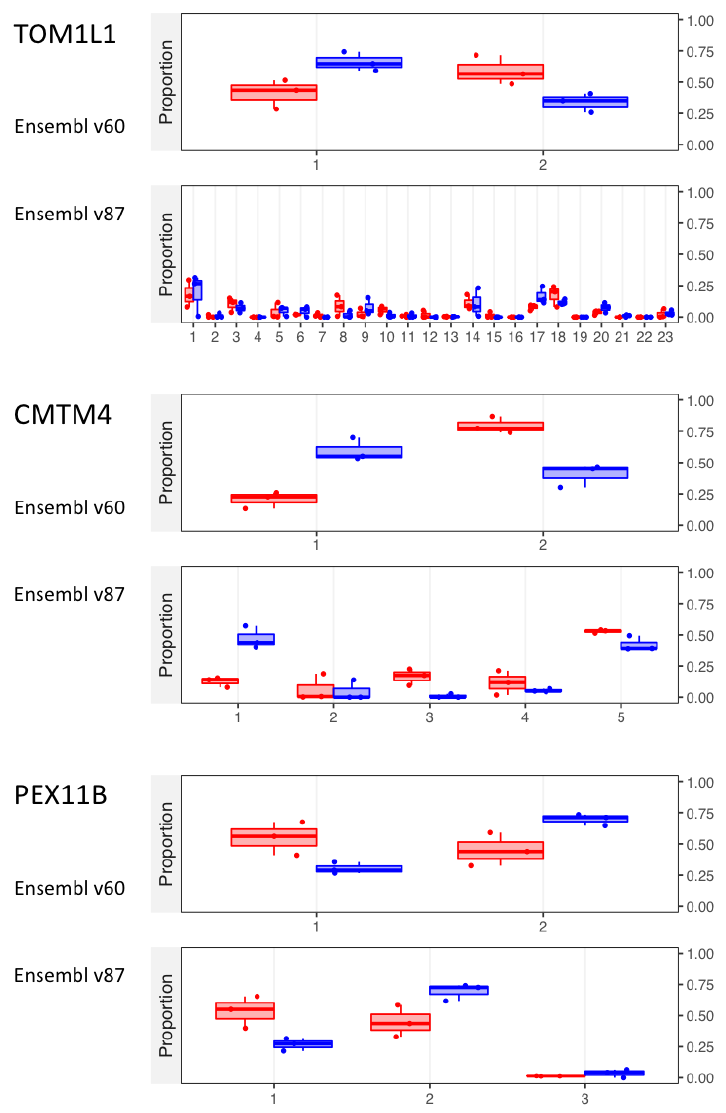
Figure 4. Relative abundance of isoforms for the three validated genes from 31, as re-quantified with Salmon 0.7.1 14 using two versions of the Ensembl annotation. Isoform IDs on the x axis were replaced with simple numbers to minimize clutter, but the mapping of number to ID is maintained between the two annotations. The y axis represents the relative abundance of each isoform. In red are the quantifications from the three replicates of the Control condition, and in blue are those from the IPF condition. The full version of the plots by RATs , including the full isoform IDs, is available in Extended data 5 33